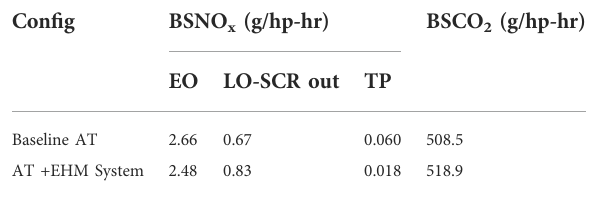
TABLE 2 FTP Composite test results.